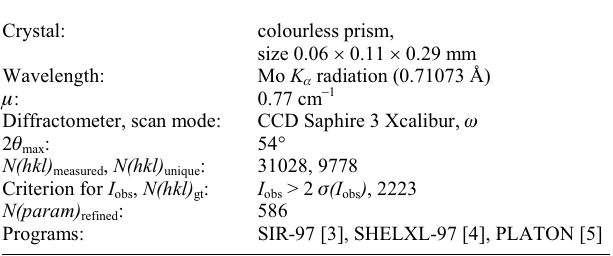
Table 1. Data collection and handling.